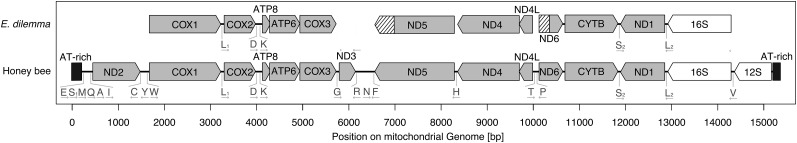
Mitochondrial genome reconstruction. The structure of the honey bee mitochondrial genome and information of the homologous reconstructed parts of the E. dilemma mitochondrial genome. Nonreconstructed parts of incompletely reconstructed genes are hatched.